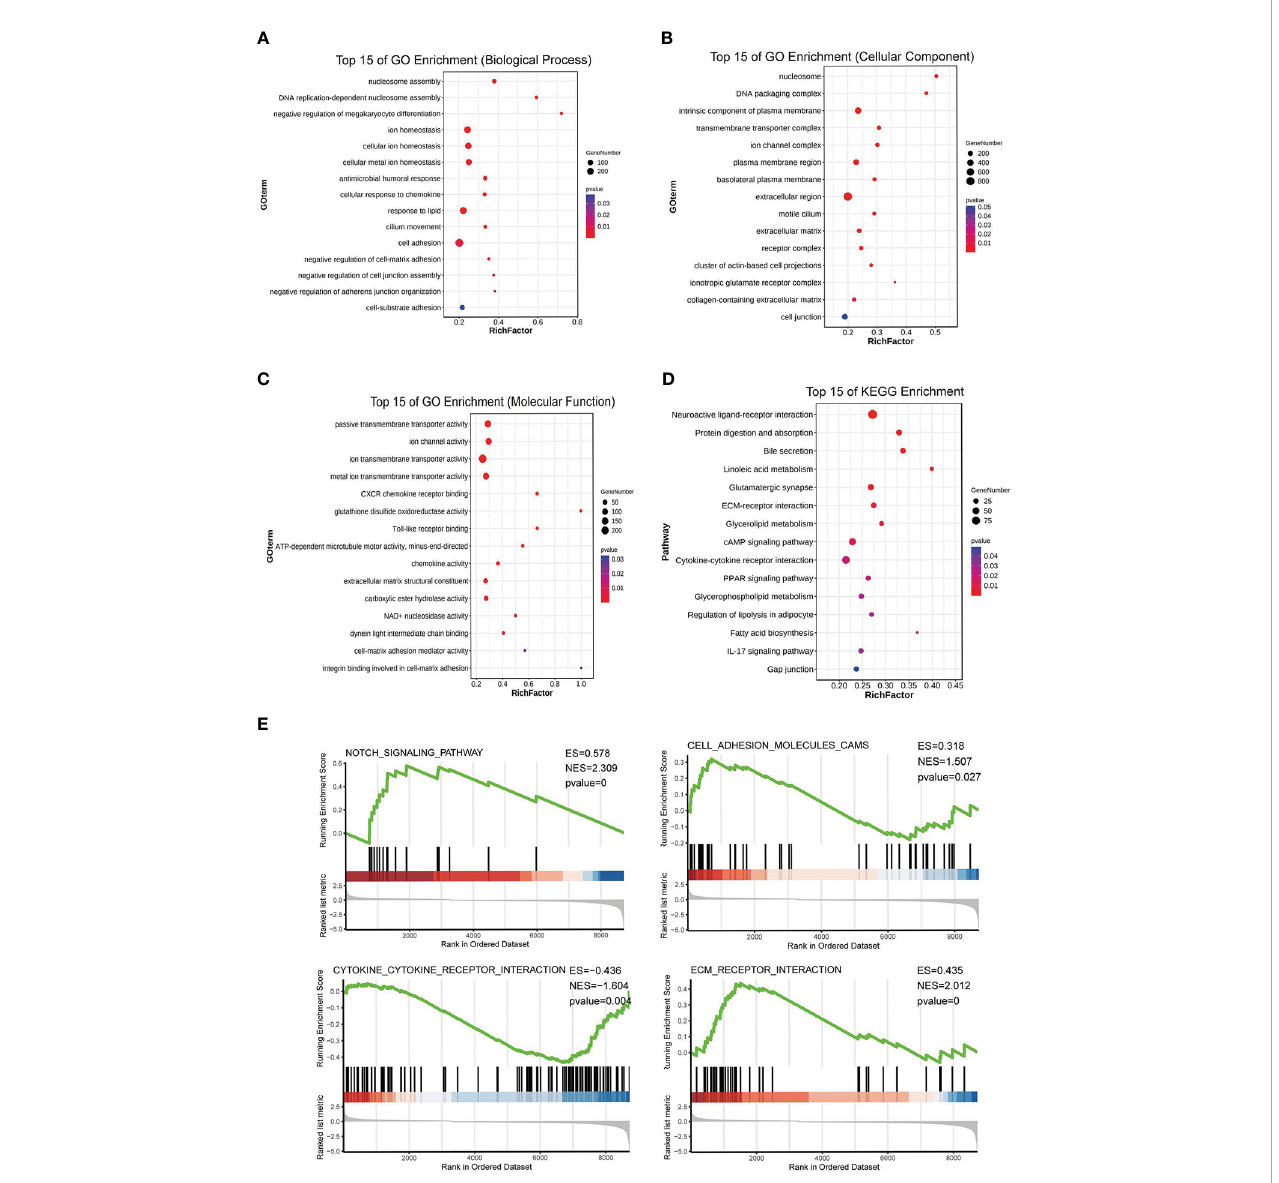
FIGURE 2 PKC d is related to the tumorigenesis and metastasis of CRC. GO enrichment analysis showed that the functions of PRKCD was related to (A) ion channels, (B) cell junctions, and (C) cell adhesion. (D, E) KEGG and GSEA pathway analysis showed that PRKCD had a relationship with four core pathways related to tumor progression and metastasis, including Notch signal pathway, cell adhesion, ECM receptor interaction, and cytokine receptor